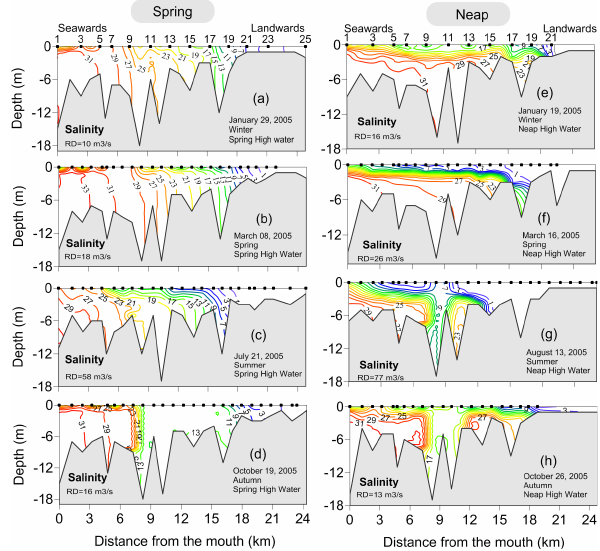
Fig. 5. Salinity distributions for all longitudinal depth surveys of the Sumjin River Estuary at high water during spring (a, b, c, d) and neap (e, f, g, h) tides in each season of 2005. The black solid circles indicate the CTD